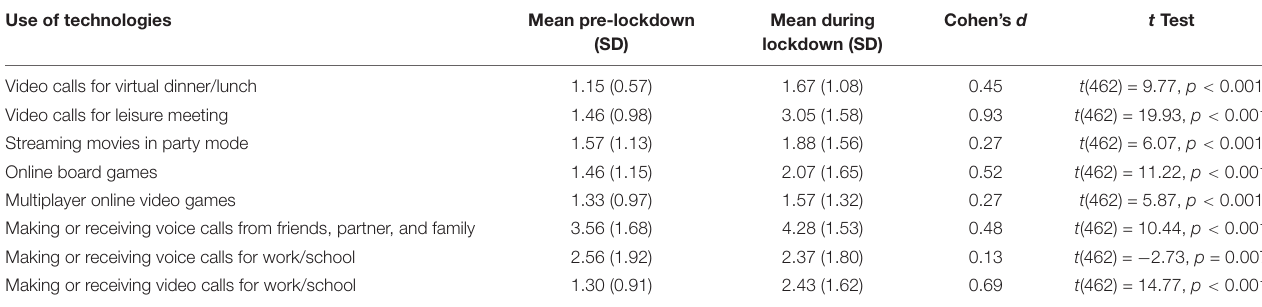
TABLE 1 | Mean comparisons for the frequency of technology use before and during the lockdown. Use of